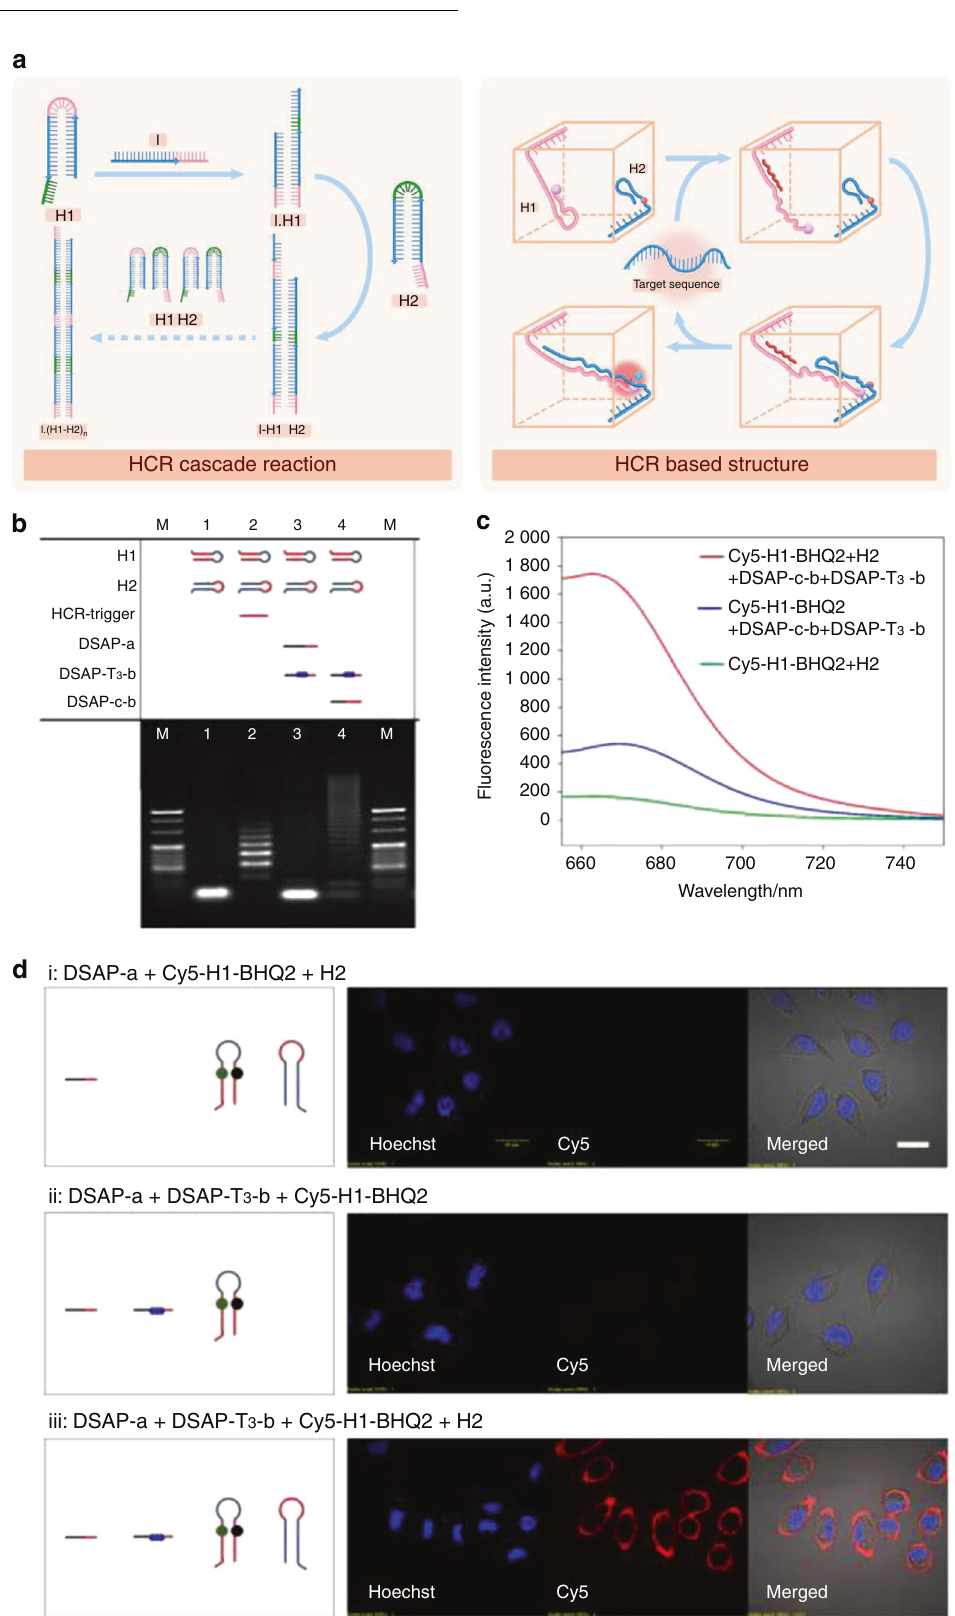
Fig. 3 Dynamic DNA structures based on strand displacement reactions. a Schematic illustration of dynamic DNA structures based on the strand displacement reaction. b The gel electrophoresis and c fl uorescence characterization results of the HCR products induced by a DSAP using DSAP- c-b to simulate target recognition. Lane M: DNA marker. d Fluorescence confocal microscopy images of target SMMC-7721 cells after incubation with different DNA probes. (i) DSAP-a + Cy5-H1-BHQ2 + H2, (ii) DSAP-a + DSAP-T 3 -b + Cy5-H1-BHQ2, and (iii) DSAP-a + DSAP-T 3 -b + Cy5-H1- BHQ2 + H2. Cells were stained with Hoechst 33342 before imaging. (Scale bar: 20 μ m). 89 Copyright 2020, American Chemical